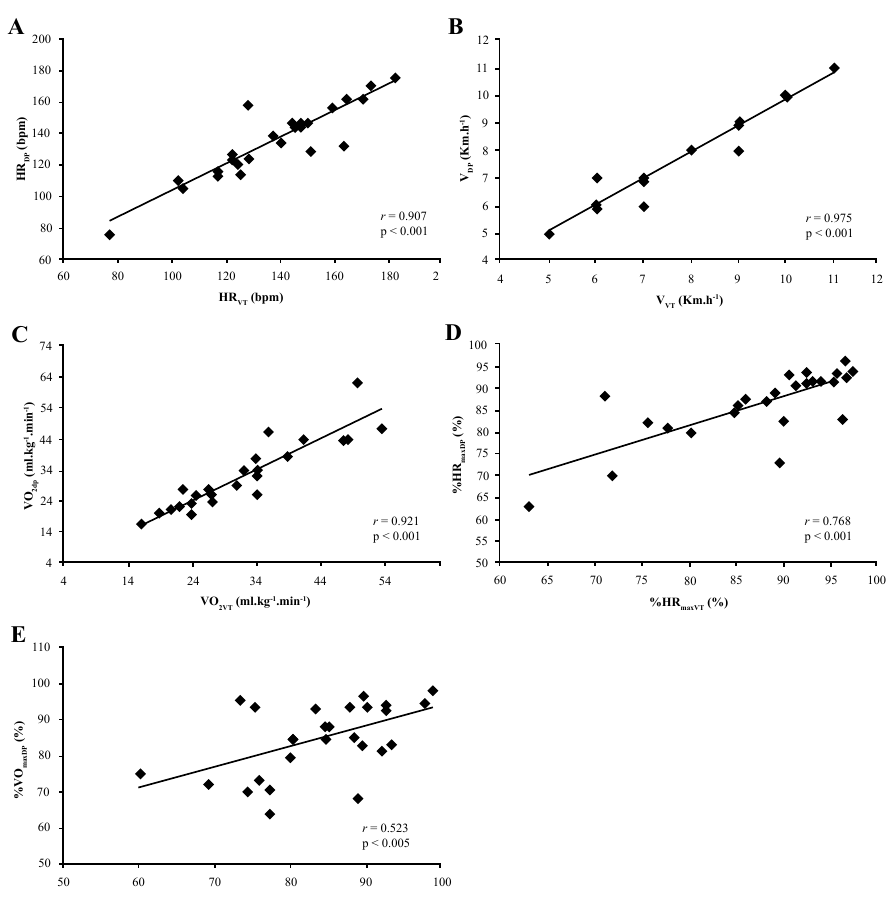
Figure 1. Correlation between the variables corresponding to HRDP and second VT for heart rate (HR) (A), velocity (B), oxygen uptake (VO (C), percentage of maximal HR (%HR Note: HRDP: heart rate deflection point; VT: ventilatory